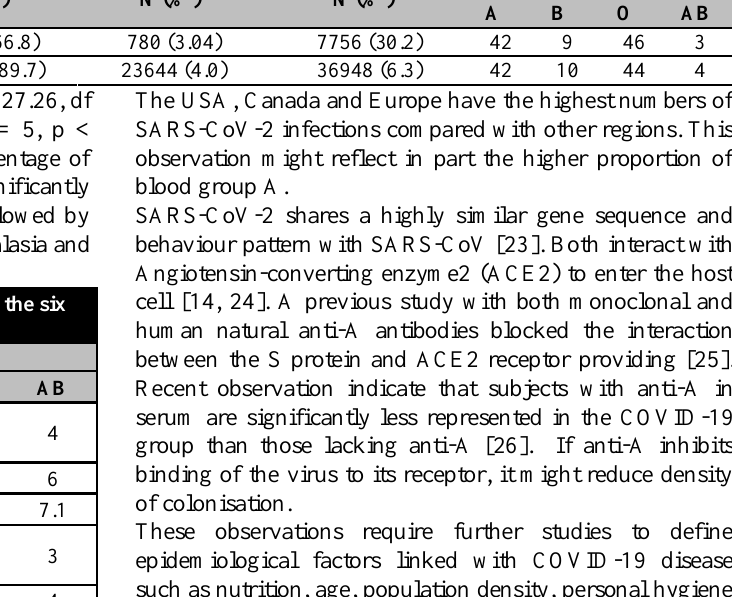
Table 6. COVID-19 in Canada and United States on the 13 th of April 2020 and the distribution of ABO blood group in these Countries